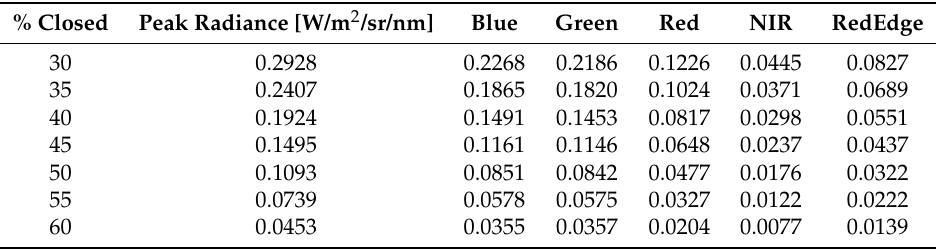
Table 2. Band integrated sphere radiances. Values were computed by applying RedEdge-3 RSR curves to the measured sphere radiances. All spectral band columns have units of W/m 2 /sr/nm. % Closed